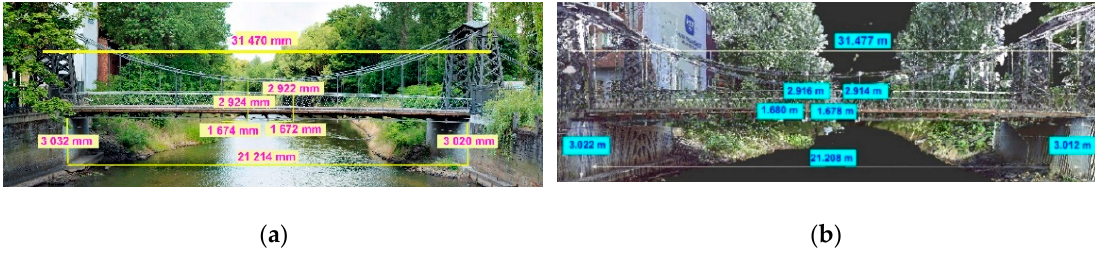
Figure 6. Controlled bridge sections and elements presented in the form of ( a ) photogram; ( b ) scan.